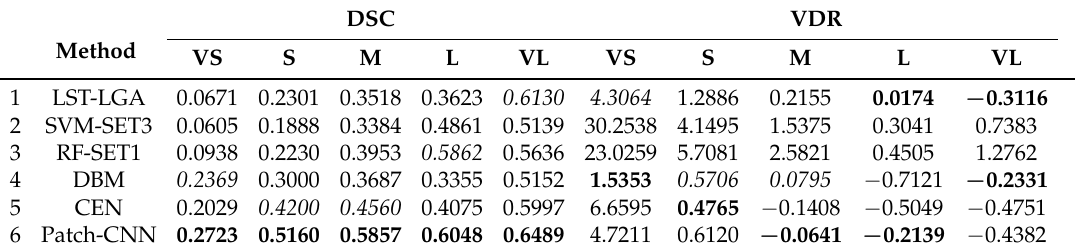
Figure 8. Distribution of DSC scores for each group based on WMH volume burden. (1), (2), (3), (4), (5) and (6) represent methods listed in Table 5, which are (1) LST-LGA, (2) SVM-SET3, (3) RF-SET1, (4) DBM, (5) CEN and (6) Patch-CNN. Table 5. Average values of dice similarity coefficient (DSC) and volume difference ratio (VDR) for grouped MRI data based on its WMH burden. VS, S, M, L and VL stand for “Very Small”, “Small”, “Medium”, “Large” and “Very Large” which are names of the groups. Higher score of DSC is better whereas near-zero VDR score is better. Values in bold are the best score for each evaluation column whereas values in italic are the second-best